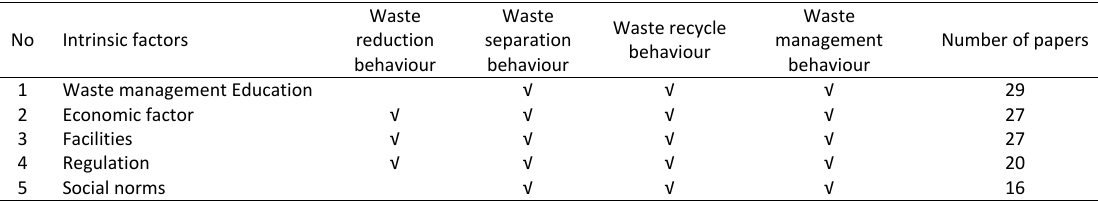
Table 5: Identified extrinsic factors affecting waste management behaviour